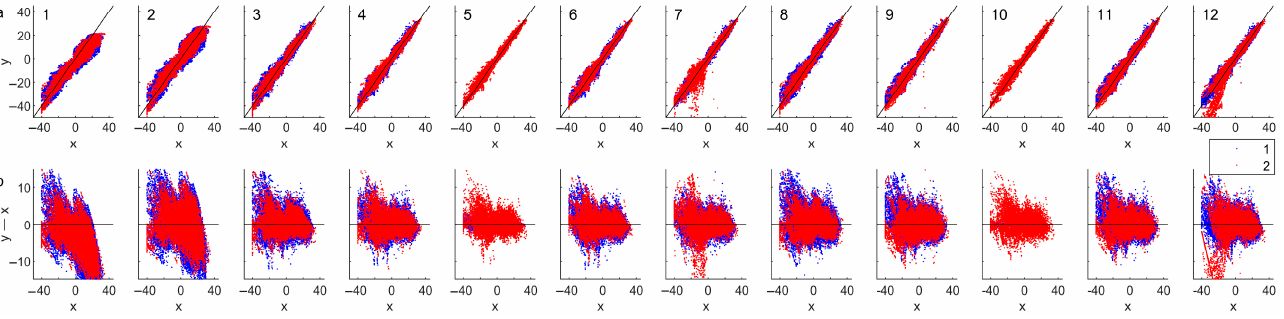
Figure 4. Results of comparison of air temperature from observations (y) and various models (x) using training (blue) and validation (red) datasets. Models: 1—ERA, 2—dbERA, 3—LM (ERA), 4—LMI (ERA), 5—GPRexp (ERA), 6—GPR2 (ERA), 7—NN (ERA), 8—LM (PCA), 9—LMI (PCA), 10—GPRexp (PCA), 11—GPR2 (PCA), 12—NN (PCA). ( a ) Observed (y) vs. modelled (x), ( b ) error (y − x) vs. modelled (x).